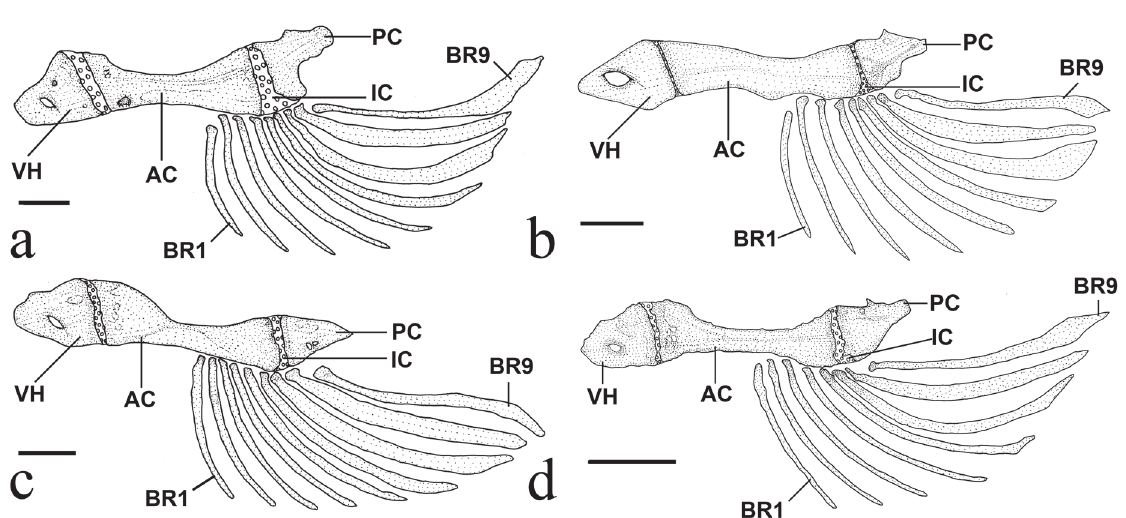
Fig. 4. Lateral view of left hyoid arch of ( a ) Trichomycterus balios , paratype, UFRGS 6831, 81.7 mm SL; ( b ) T . diatropoporos , paratype, UFRGS 16237, 57.8 mm SL; ( c ) T . poikilos , paratype, MCP 22699, 79.0 mm SL; and ( d ) T . brachykechenos , paratype, UFRGS 16245, 41.9 mm SL. Abbreviations: AC, anterior ceratohyal; BR1-9, branchiostegal rays 1 to 9; IC, inter-ceratohyal cartilage; PC, posterior ceratohyal; VH, ventral hypohyal. Scale bar = 1 mm.